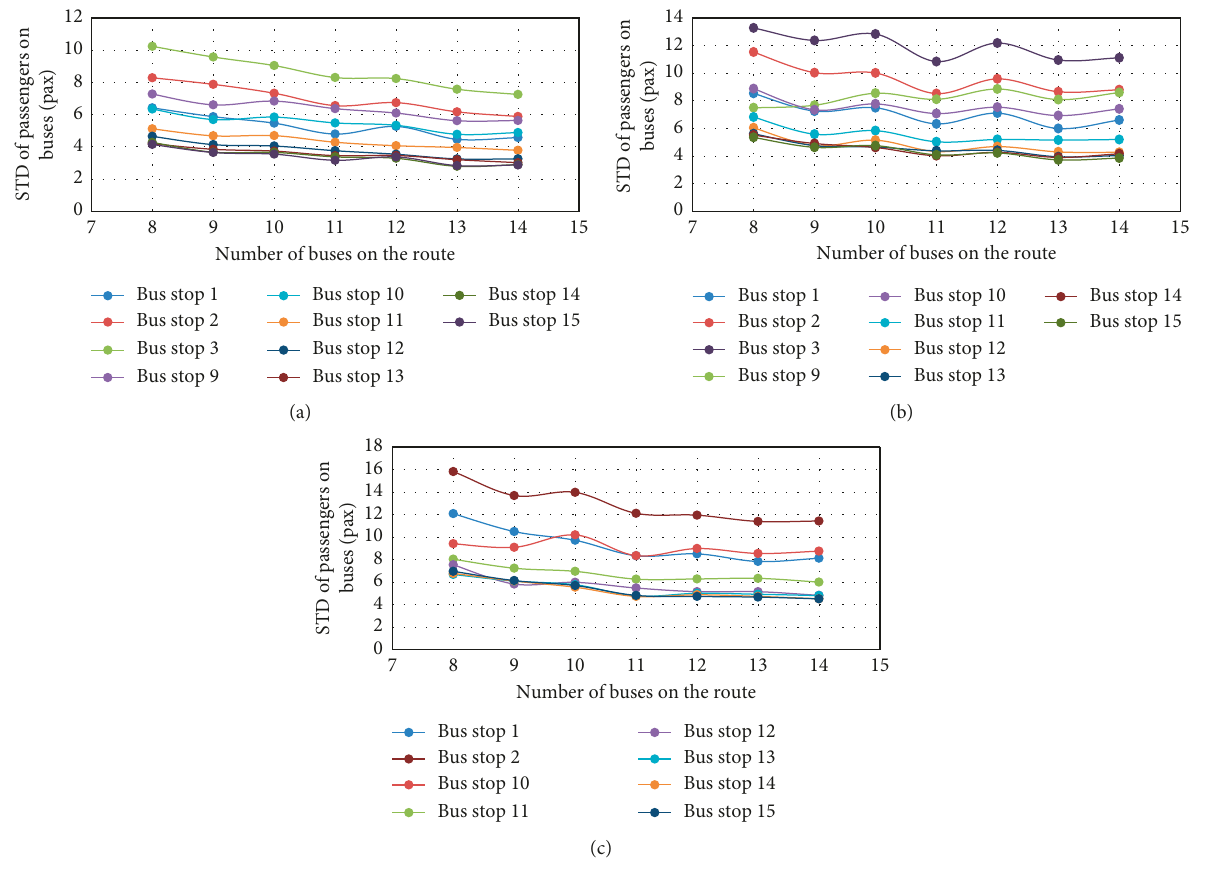
Figure 11: STD of passengers on buses at bus stops located at relatively empty section. (a) Group r1. (b) Group r2. (c) Group r3.